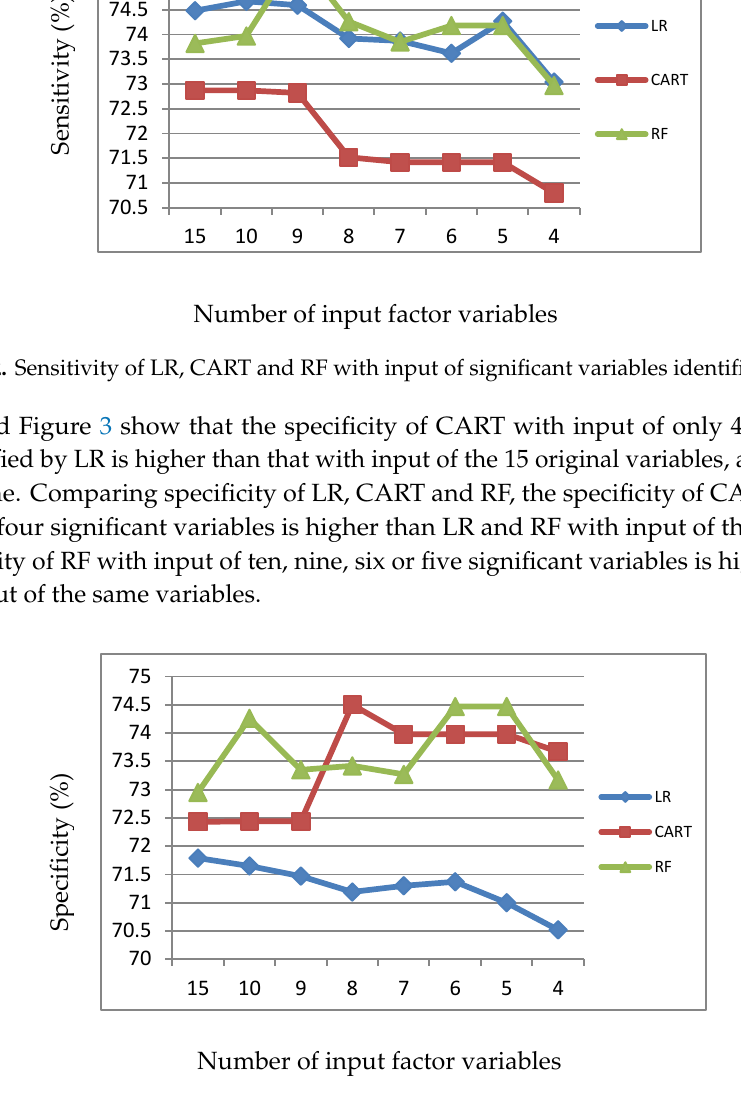
Figure 3. Specificity of LR, CART and RF with input of significant variables identified by LR.